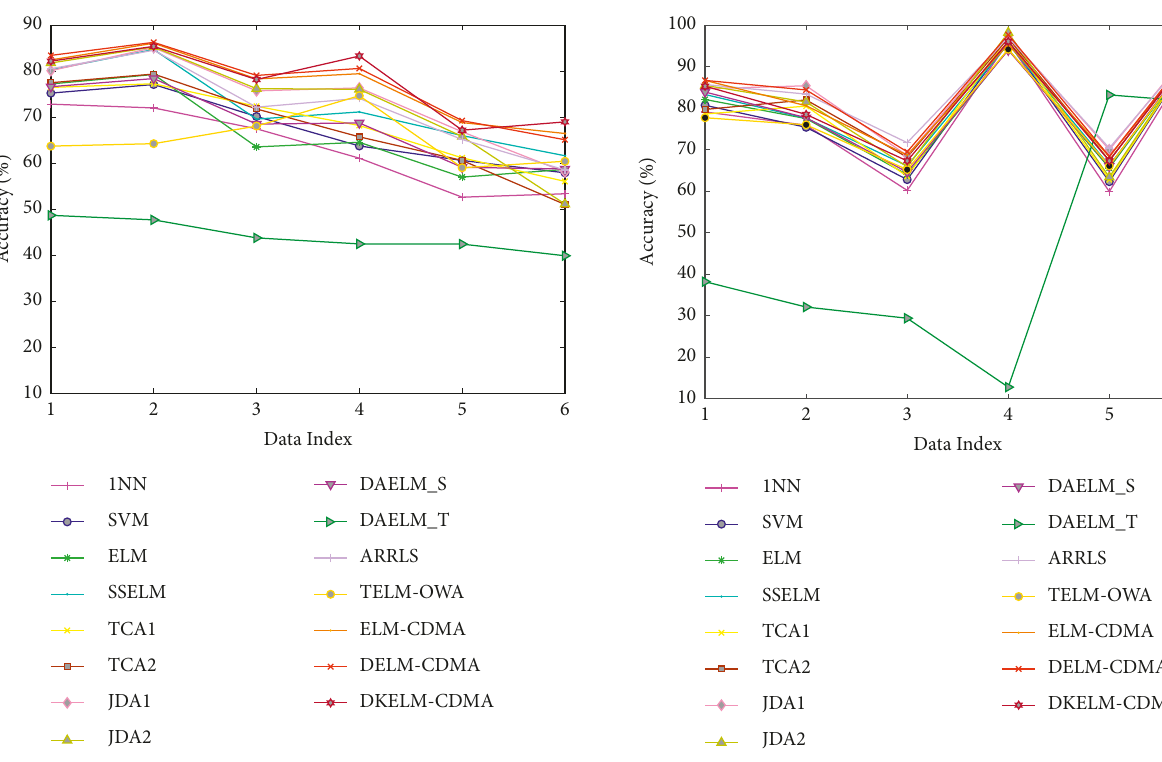
Figure 10: Classification accuracy of different algorithms on office- 31 data